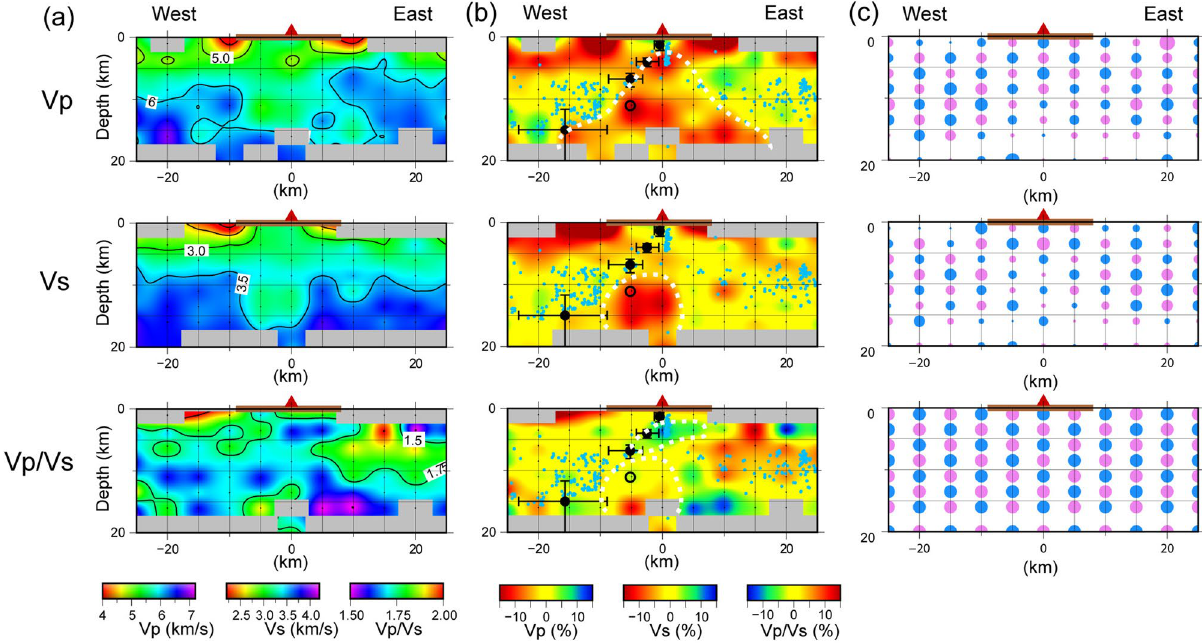
Figure 5. East–west cross-sections of the three-dimensional seismic velocity model across Mt. Fugendake. The red triangle and brown bar at the top of each panel represent Mt. Fugendake and Shimabara Peninsula, respectively. (a) Absolute values. (b) Perturbations from the averaged structure. The sky-blue dots indicate hypocenters used in this study that are located within 2 km of the cross-section. The low-Vp, low-Vs, low-Vp/ Vs, and moderate–high Vp/Vs zones discussed in the text are shown by white dashed lines. Black solid circles with error bars and open circle indicate the pressure sources of Kohno et al. (2008) and Nishi et al. (1999), respectively. The symbols are as in Fig. 1. (c) Result of